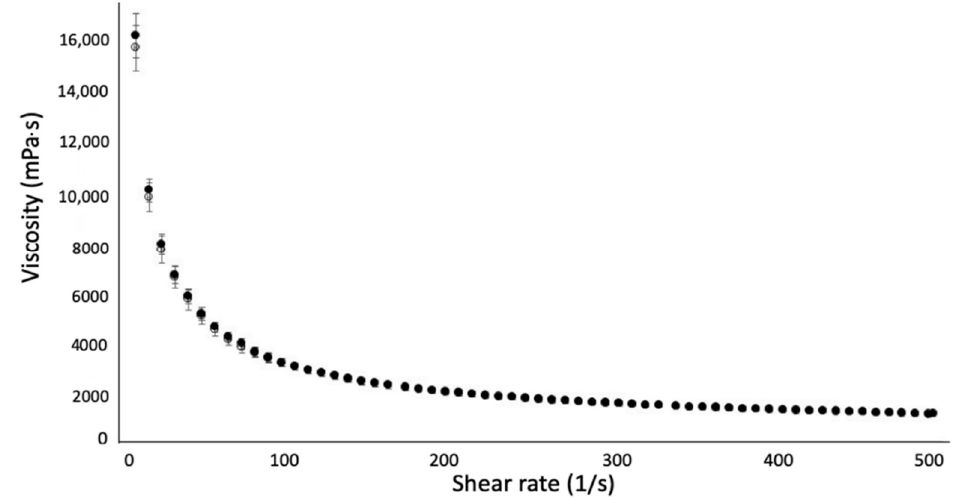
Figure 11. Rheological measurement over time of the rapamycin micellar hydrogel 0.1% (formula- tion F3) at day 0 (empty round) versus day 90 (full round).